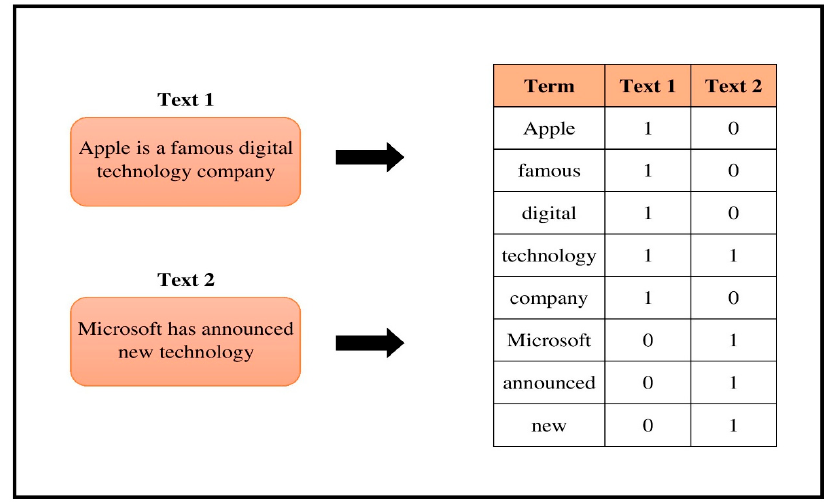
Figure 8. BOW with two text documents represented as binary vectors.